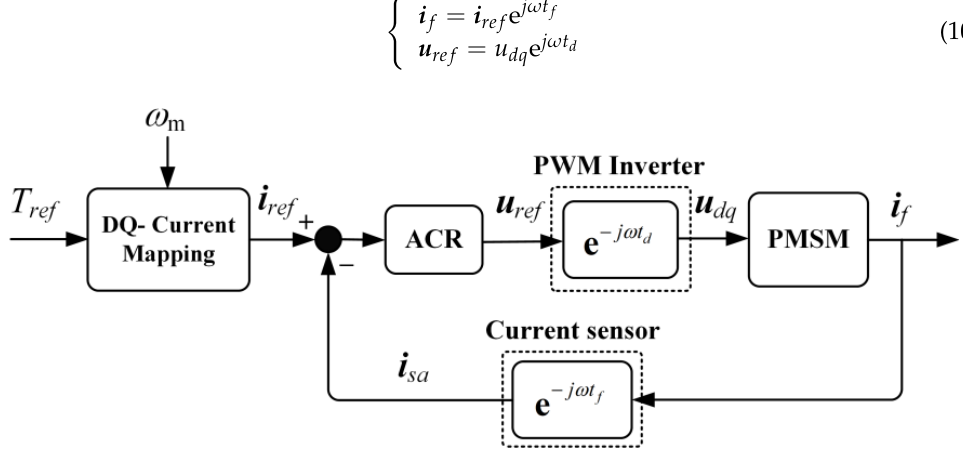
Figure 6. Influence of permanent magnet flux change on torque control system.